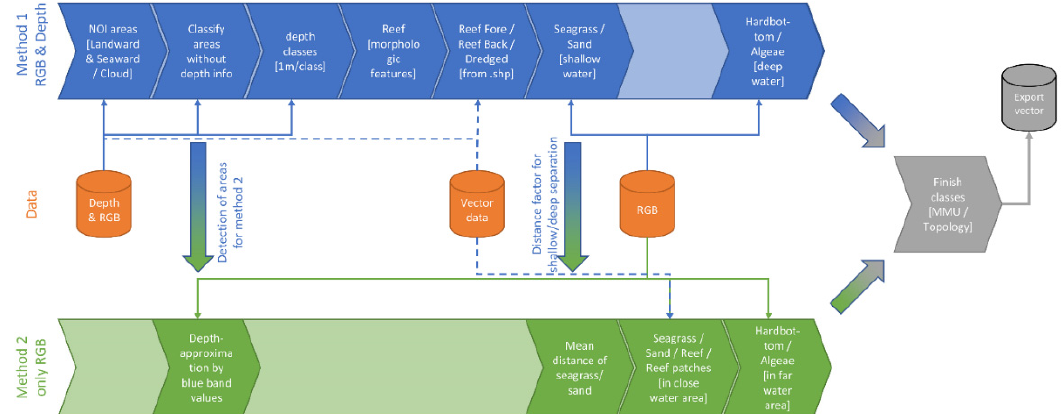
Figure 8. The eCognition classification workflow that integrates RGB spectral data, bathymetry, and geomorphic zone vector data. This method employs two parallel tracks for mapping areas with and without bathymetric data.